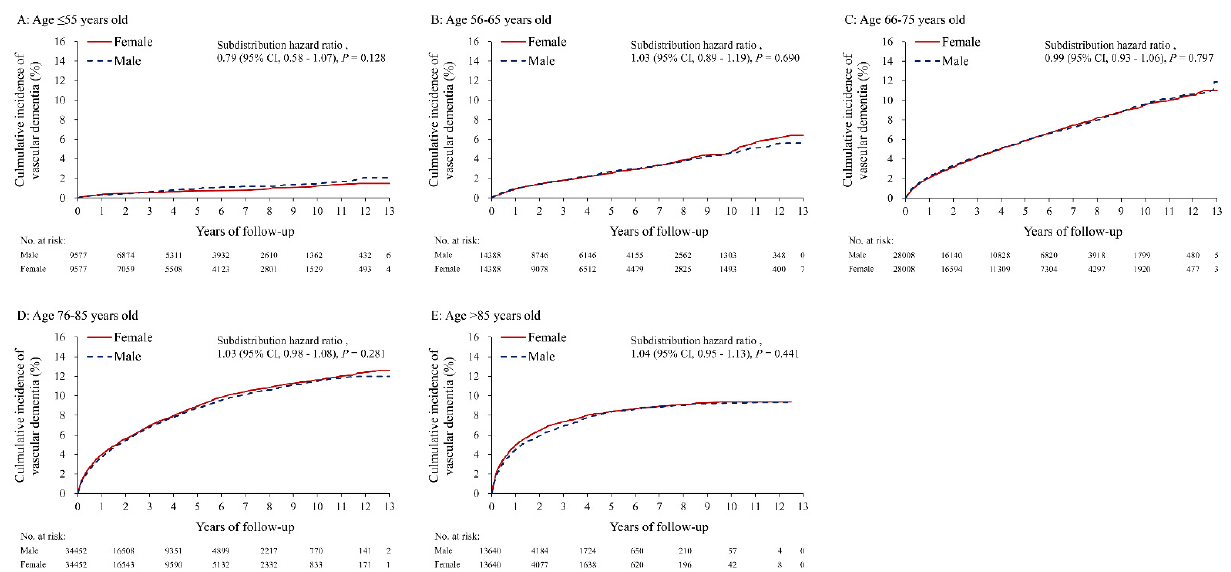
Figure 5. The cumulative incidence (under the Fine and Gray sub distribution model) of vascular dementia between male and female patients with atrial fibrillation stratified by age in the propensity score matched cohort. (A) age ≤ 55 years old,